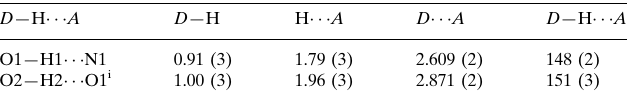
Data collection Nonius KappaCCD diffractometer Absorption correction: multi-scan